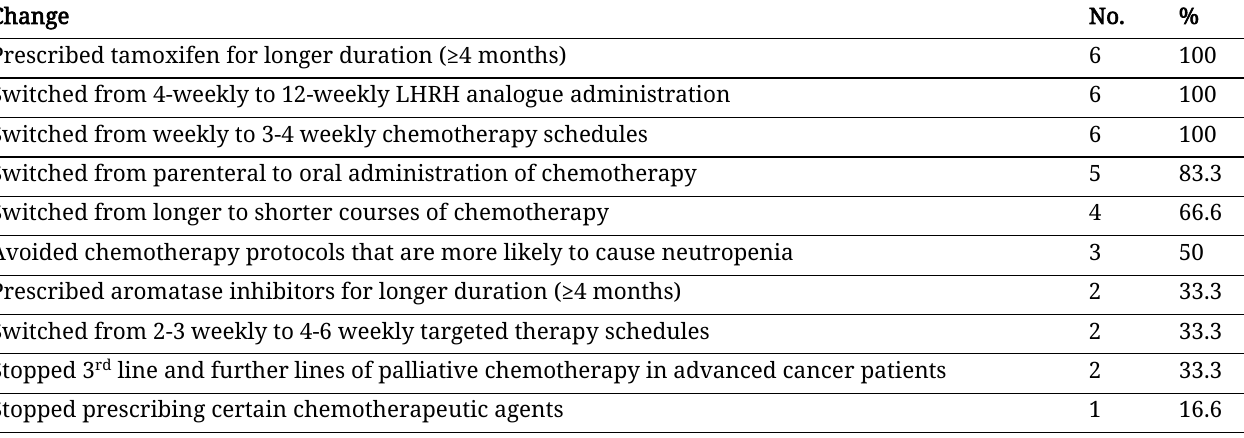
Table 1: Change of practice related to systemic anti-cancer treatment Change